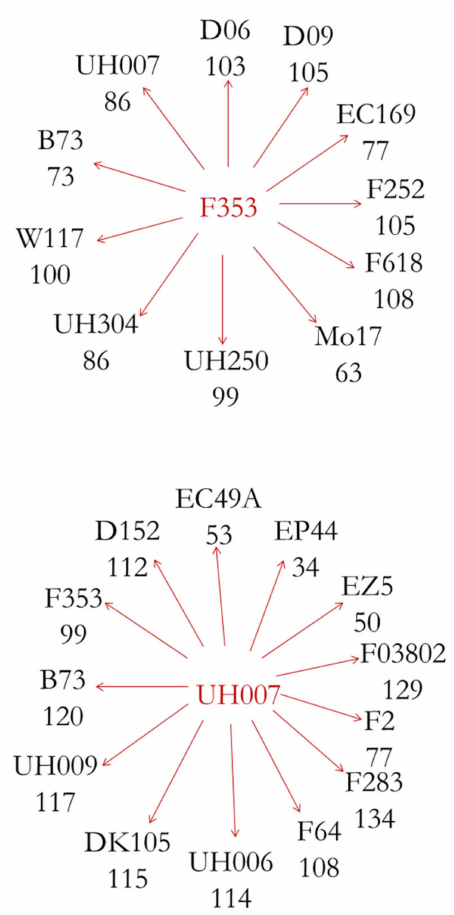
Figure 1. Nested Association Mapping populations with 11 inbred parents and the double haploids (DH) obtained from each cross with the central Dent parent F353 ( above ), and 13 inbred parents and the DH obtained from each cross with the central Flint parent UH007 ( below